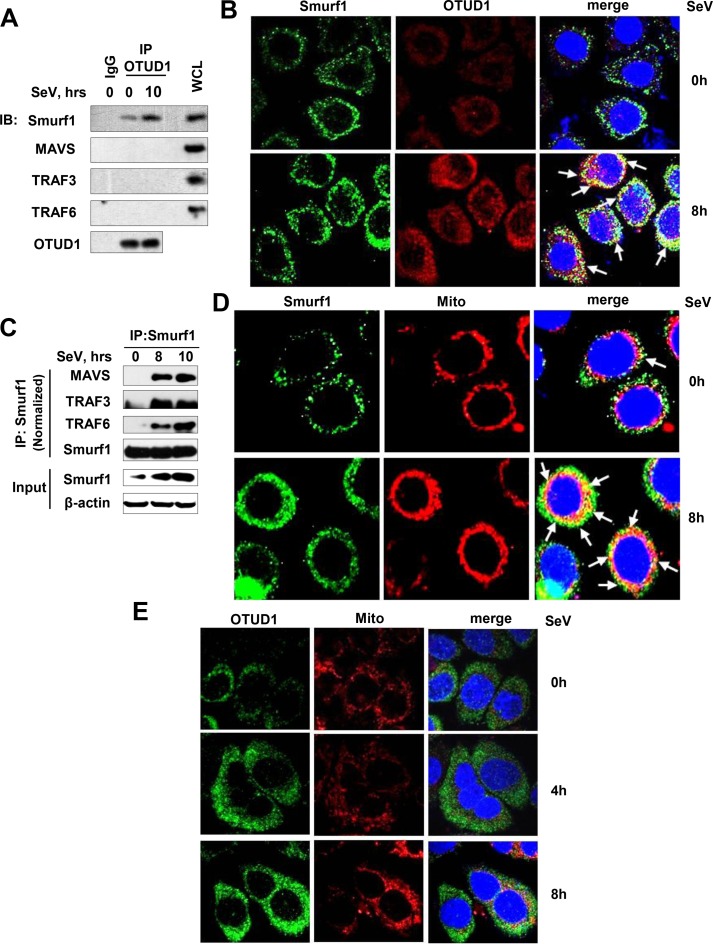
RNA virus infection promotes the interaction between OTUD1 and Smurf1, and binding of Smurf1 to MAVS/TRAF3/TRAF6.(A) 2fTGH cells were infected with SeV (MOI = 3) for 10 hr. Endogenous OTUD1 protein was immunoprecipitated, and the indicated proteins were tested by immunoblotting. The whole cell lysates (WCL) were used as a positive control. (B) HepG2 cells were infected with SeV (MOI = 3) for 8 hr, and then were stained by Smurf1 and OTUD1 antibodies. Cell nuclei were stained by DAPI. The fluorescent images were captured with the Nikon A1 confocal microscope. (C) Mouse BMDMs were infected with SeV (MOI = 3) for the indicated time. Endogenous Smurf1 protein was immunoprecipitated, and the indicated proteins were tested by immunoblotting. (D) HepG2 cells were infected as (B), and then were stained by a Smurf1 antibody. MitoTracker Red CMXRos was used for staining for mitochondria. (E) HepG2 cells were infected with SeV (MOI = 3) for 4 and 8 hr, and then were stained by an OTUD1 antibody or MitoTracker Red CMXRos. Data are representative of three independent experiments.